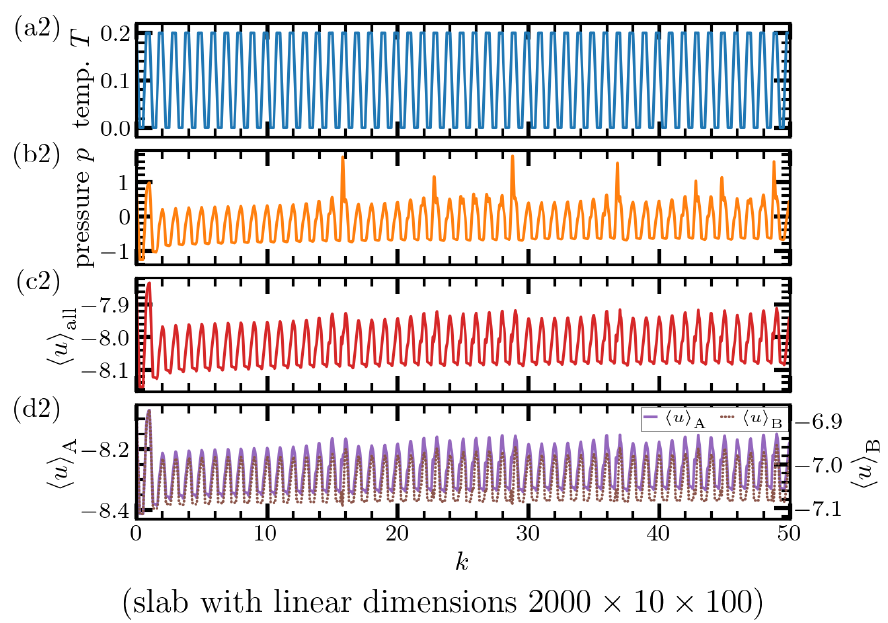
Figure 2. Temperature ( a ), pressure ( b ), and per-particle potential energy of all ( c ) and respective atoms types ( d ) during 50 thermal cycles with a cycling period τ tc = 500. The upper image ( a1 – d1 ) shows the result for a cubic simulation box with a linear dimension of roughly 128 particle diameters. The lower image ( a2 – d2 ) corresponds to the slab geometry, where the largest linear dimension reaches 2000 particle diameters. In the case of cube T , p and (cid:104) u (cid:105) follow the prescribed cyclic variation of temperature, which is imposed by the Nosé–Hoover thermostat. In marked contrast to this, the slab develops a significantly different response. Both pressure and per-particle energy develop a more complex time dependence, with small-amplitude oscillations at the frequency of the imposed cyclic perturbation modulated by slower amplitude-variations. In the case of pressure ( b2 ), irregular jumps are observed, indicative of random release of the energy, which is accumulated over the course of preceding cycles. The fact that kinetic energy follows the prescribed curve is reassuring and shows that thermal cycling is sufficiently slow for the relaxation of kinetic energy to the prescribed